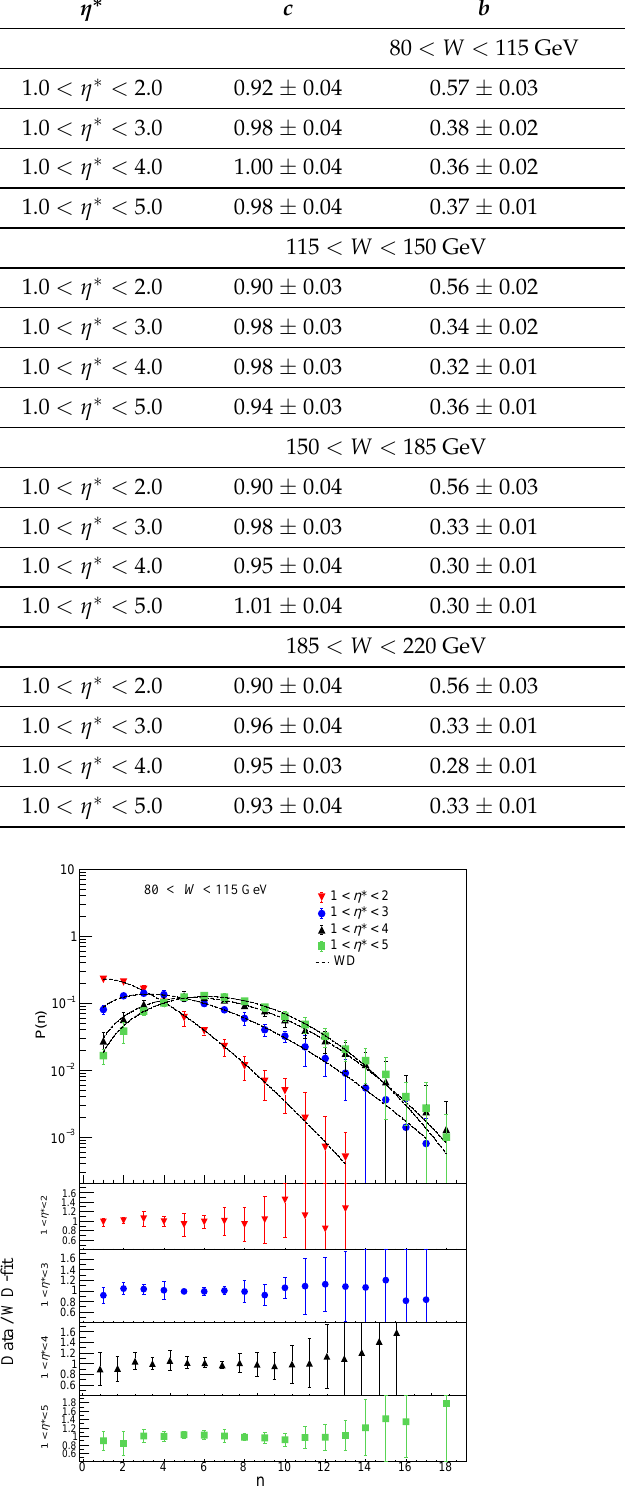
Figure 6. Multiplicity distributions fits with Weibull (WD) probability function in 80 < W < 115 GeV in different η ∗ ranges of the H1 data [33]. The lower panel shows the data/WD-fit ratio plots for different η ∗